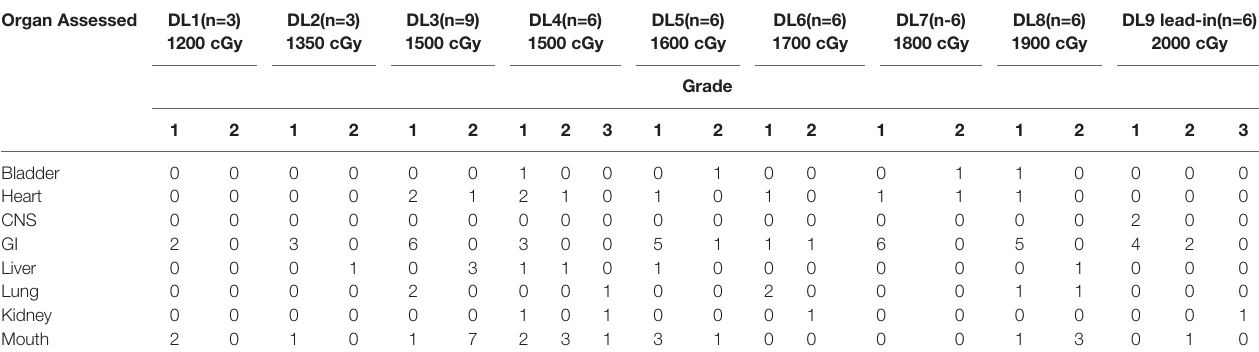
TABLE 2 | Toxicities by dose level for TMLI study